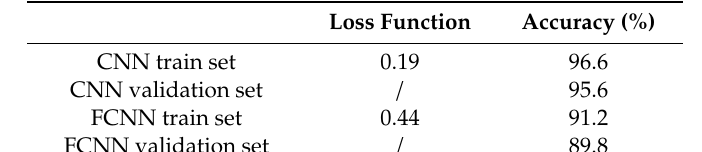
Table 6. Model prediction accuracy.